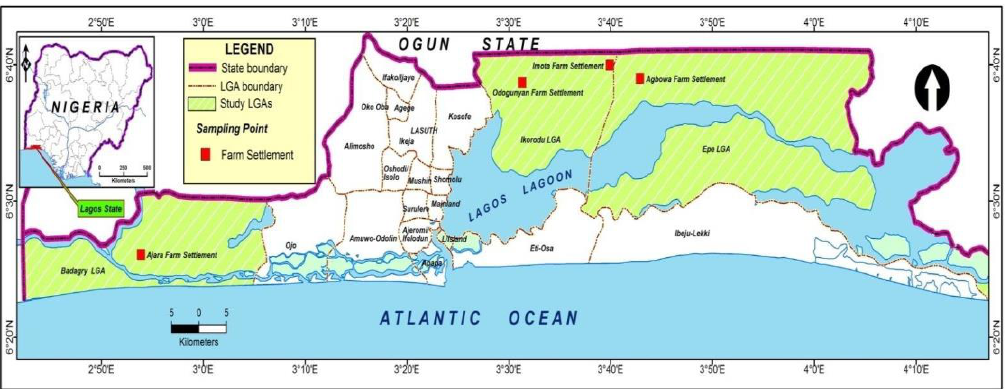
Figure 1. The map of the study area. Source: Author’s Fieldwork (2019).